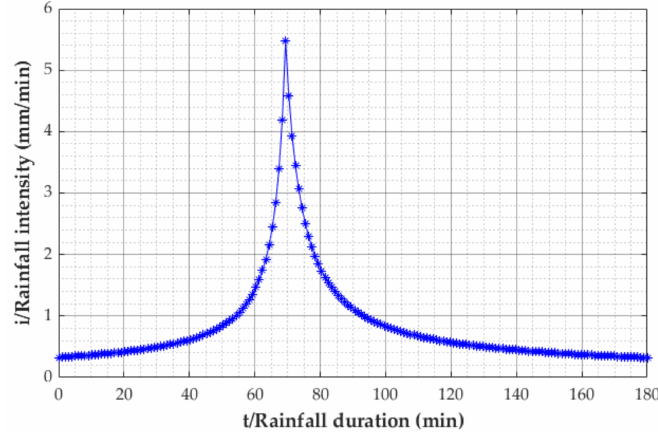
Figure 8. Rainfall Process